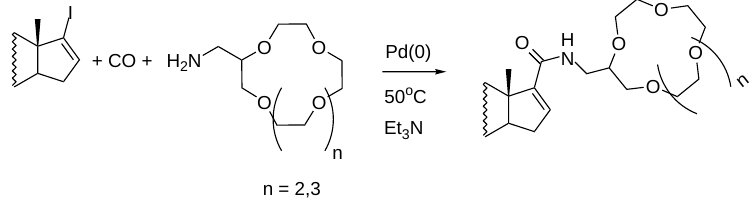
Figure 15. Preparation of steroidal crown ethers.